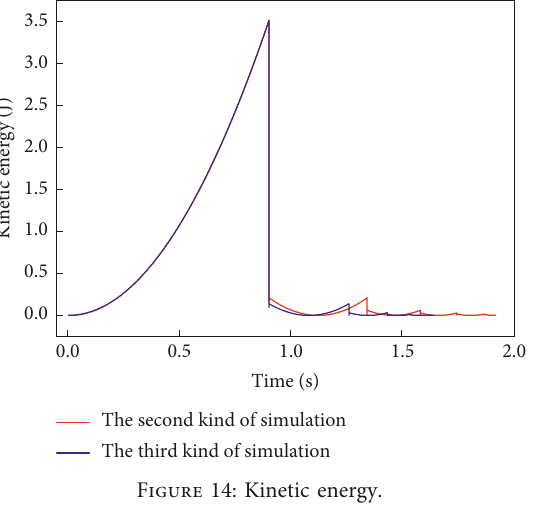
Figure 17: Angular kinetic